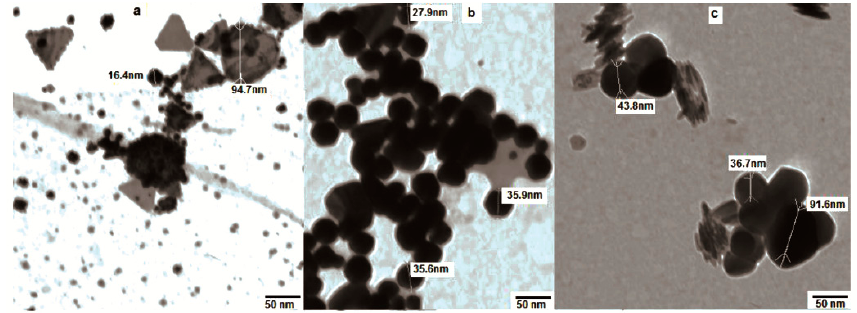
Figure 3. Transmission electron microscopy (TEM) images of Au NPs in the presence of different volumes of the broth extract: ( a ) 2 mL, ( b ) 3 mL, and ( c ) 4 mL.